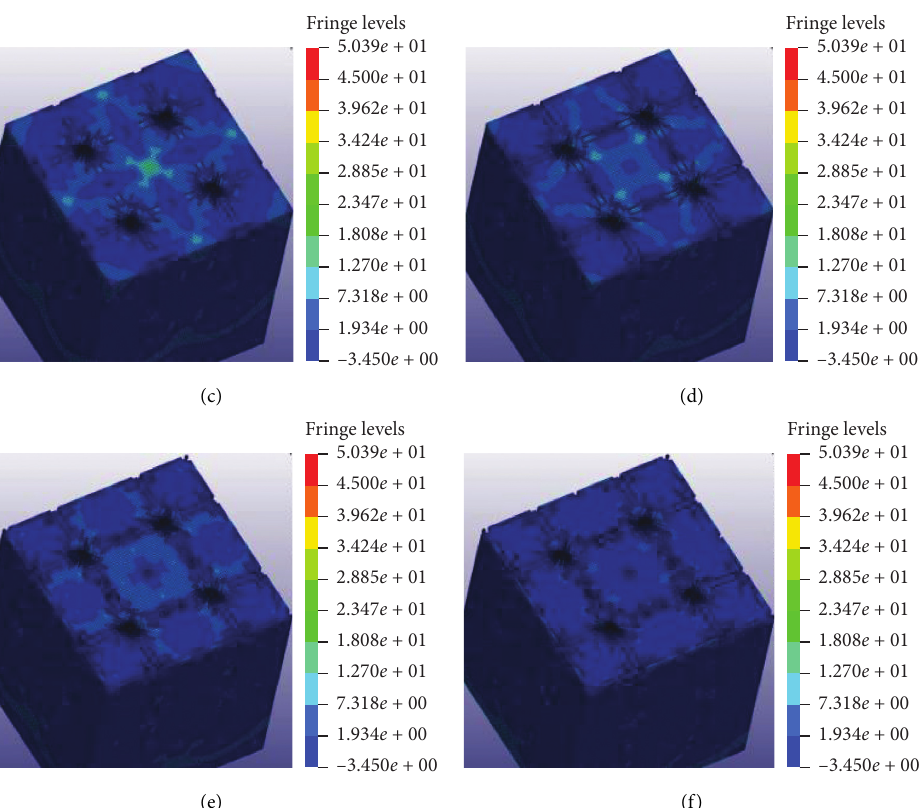
Figure 9: The whole process of a loading concrete beam segment with double-row holes. (a) t � 55 μ s. (b) t � 75 μ s. (c) t � 85 μ s. (d) t � 95 μ s. (e) t � 120 μ s. (f) t � 160 μ